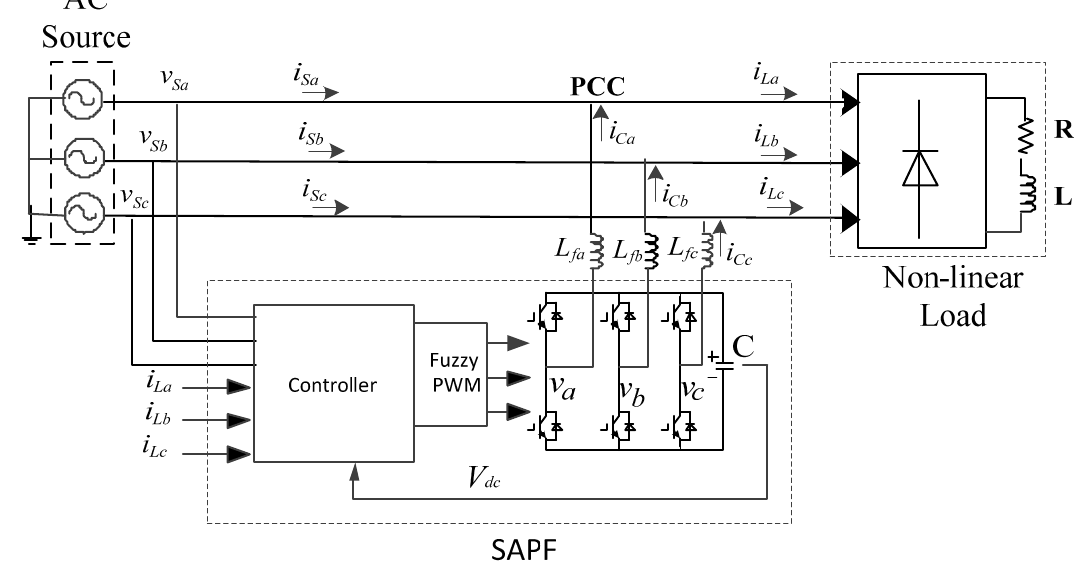
Figure 1. Block diagram of the three phase shunt active power filter (SAPF).